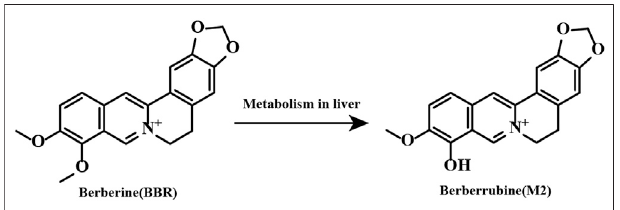
FIGURE 1 | Chemical structures of BBR and its main metabolite